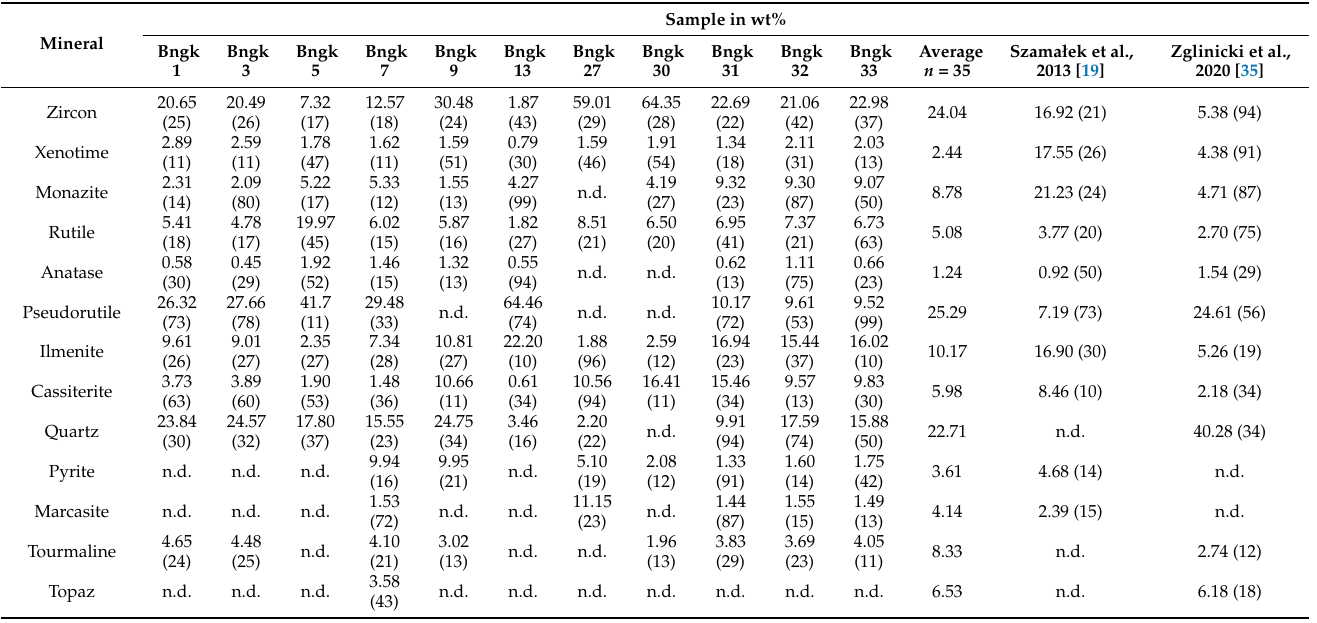
Table 2. Mineral composition of selected tailings samples from Bangka Island. X-ray diffraction analyses. In brackets, the expanded